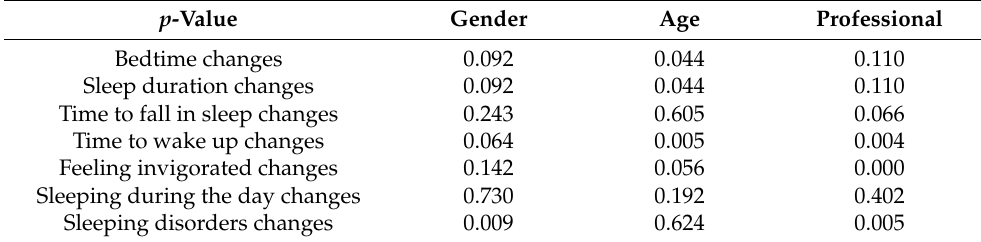
Table A1. p -value, changes: bedtime, sleep duration, time to fall in sleep, time to wake up, wake up, feel invigorated, during the day, disorders, by gender, age and professional